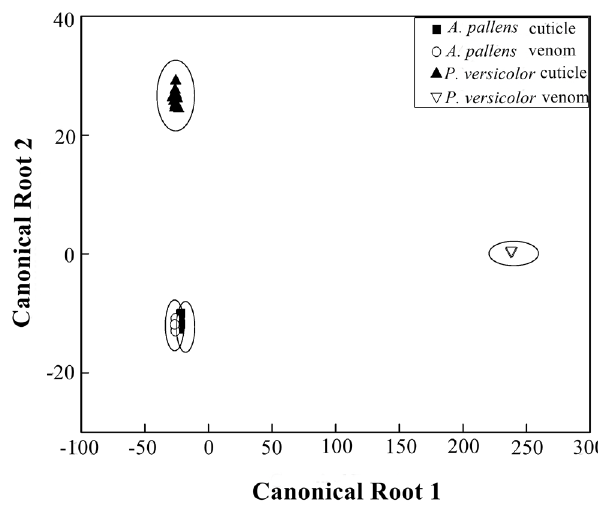
Fig 3. Dispersion diagram showing the differences in cuticular chemical profiles and chemical profile of nonpolar compounds of venom of Apoica pallens and Polistes versicolor wasps. Wilk’s Lambda = 0.001, p < 0.001 and F =